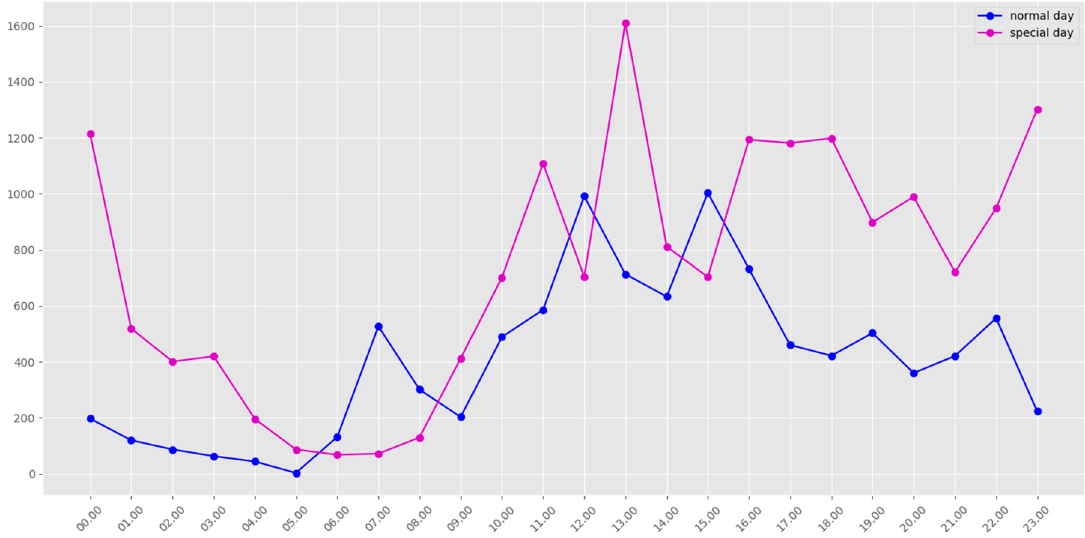
Figure 3. Clustering results in New York City on a normal day and New Year’s Eve day.